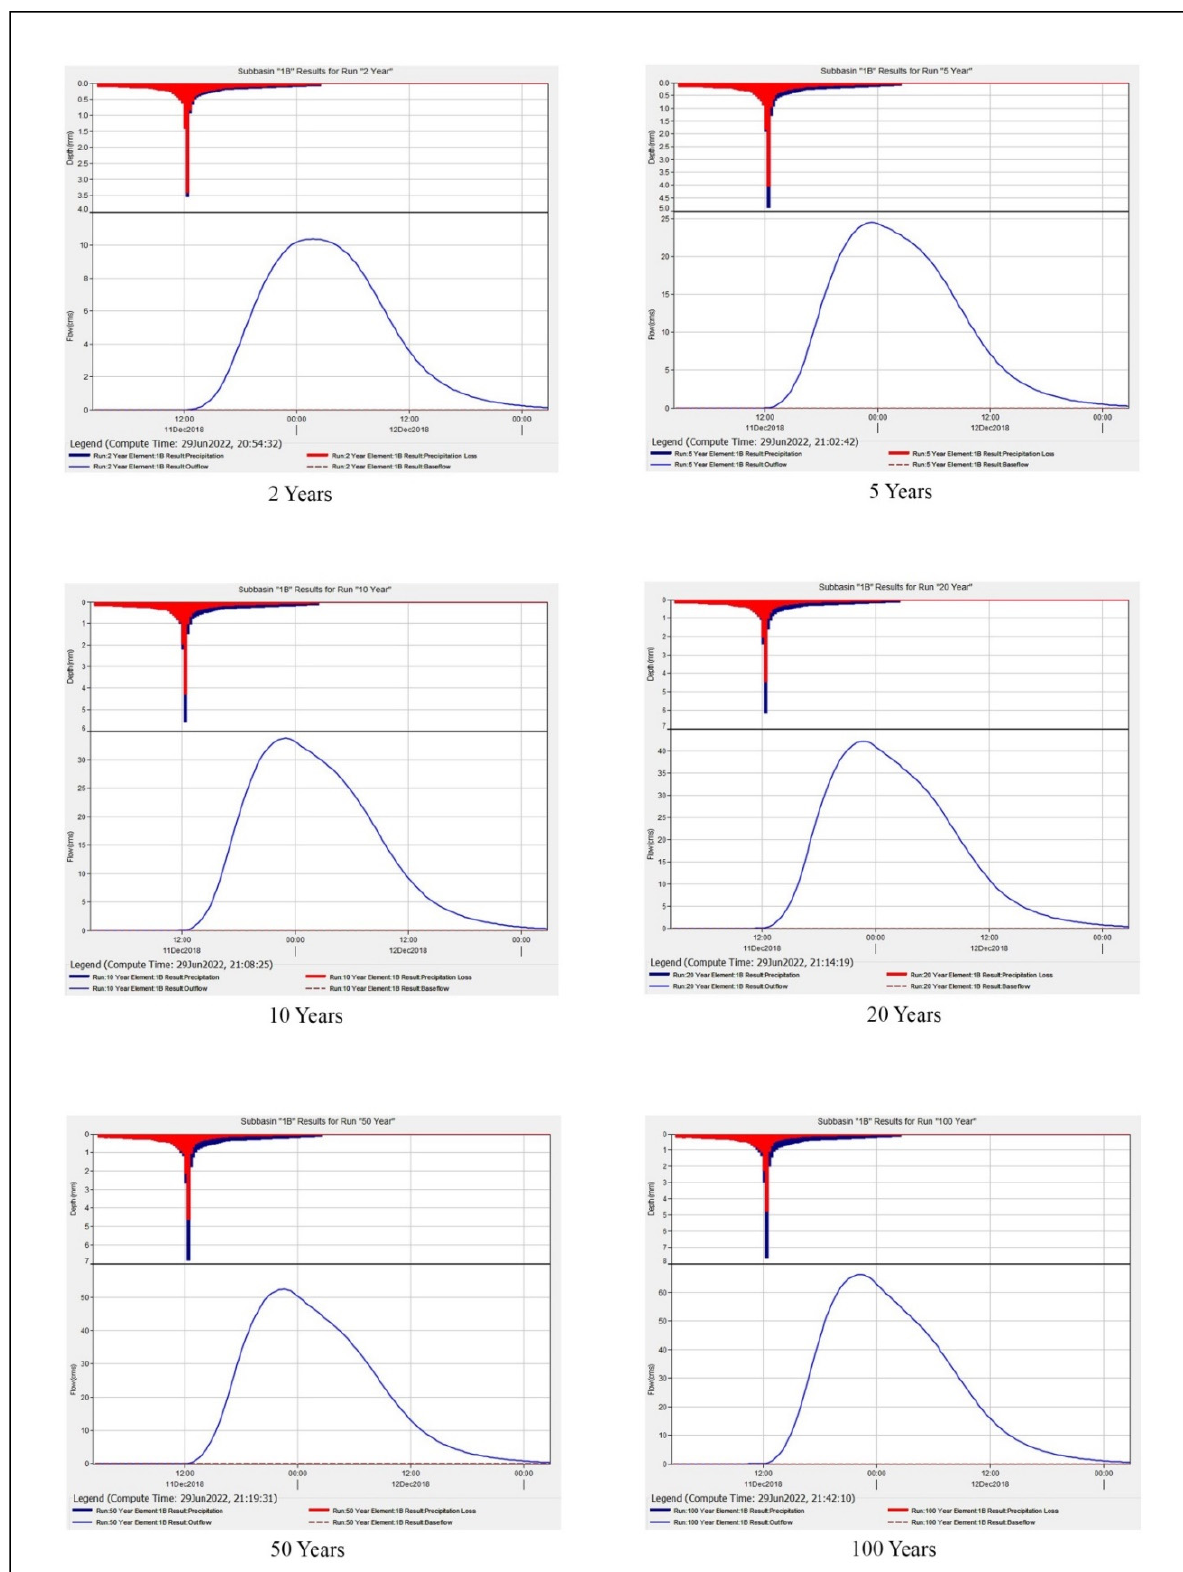
Figure 8. Hydrograph of the flood water of the Khazir River Basin for return periods: a- 2 years, b- 5 years, c- 10 years, d- 20 years, e- 50 years and f- 100 years.